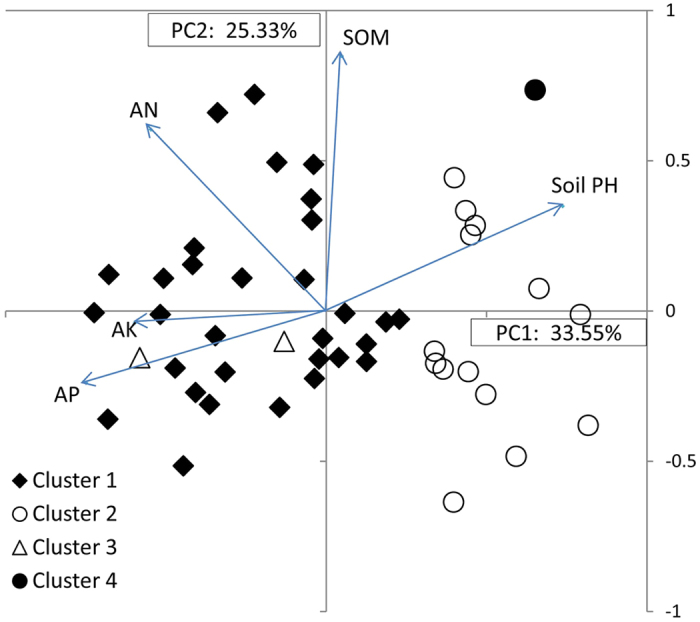
Principal components analysis of 48 soil samples of the mung bean production areas.Variable factor loadings for PC1 and PC2 are soil pH and soil nutrient variables and presented as vectors.